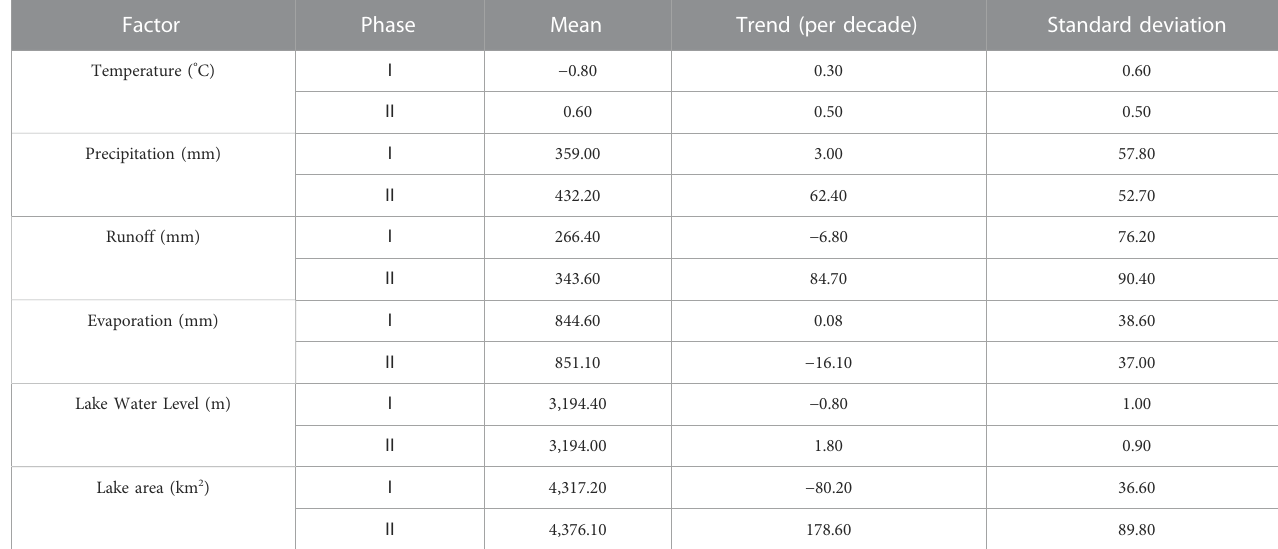
TABLE 1 Statistics of factors affecting the water balance of Qinghai